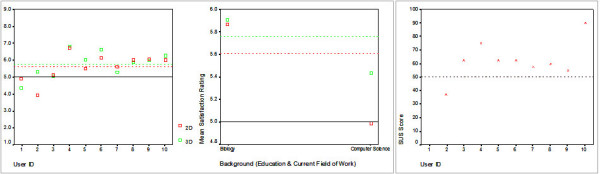
User satisfaction ratings for the structured evaluation of the visualisation prototypes. The two charts on the left show the mean overall satisfaction ratings for each of the 2D and 3D browsers. The first chart shows means for each user and the second, means by target user group. The colour coded reference lines for each chart show the mean overall satisfaction rating for each browser, while the black reference line shows the midpoint for the Likert scale (ranked 1–9) for the questions posed. The third chart plots SUS scores for each user (note there is no score for user 1).